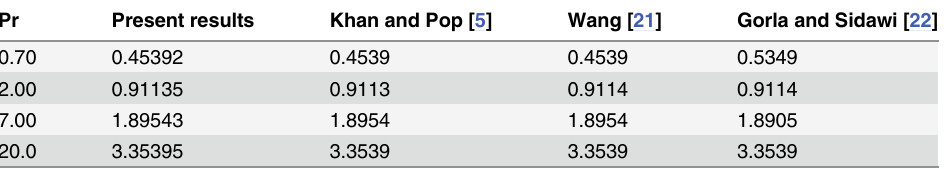
Table 1. Comparison of the present results of local Nusselt number – θ 0 (0) for the case of Newtonian fluid with the results of Khan and Pop [5], Wang [21] and Gorla and Sidawi [22]. Pr Present results Khan and Pop [5] Wang [21] Gorla and Sidawi